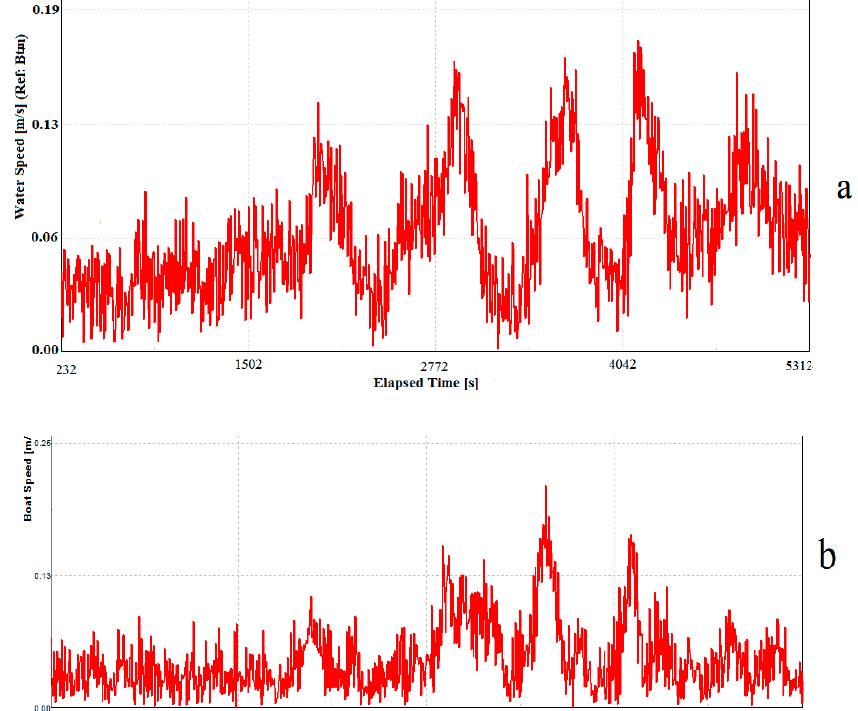
Figure 3. ADCP recording of the displacement velocity of the moored vessel ( b ) and the current velocity ( a ) during the passage of the train of internal waves.